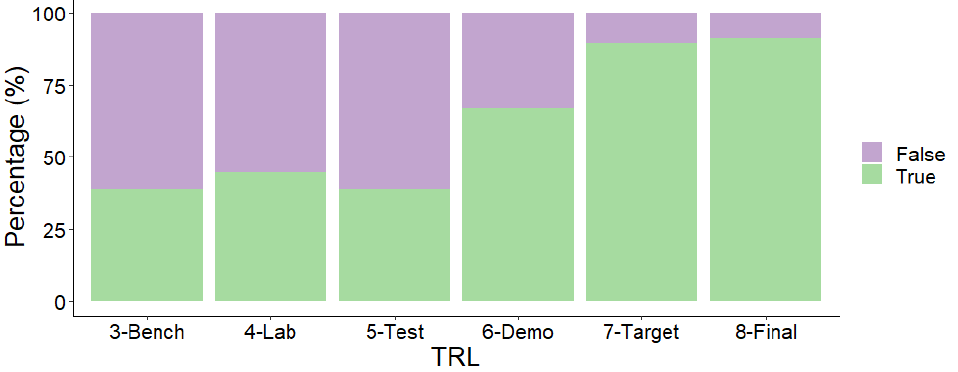
Figure 5. Deployment distribution between TRL and existence of a goal